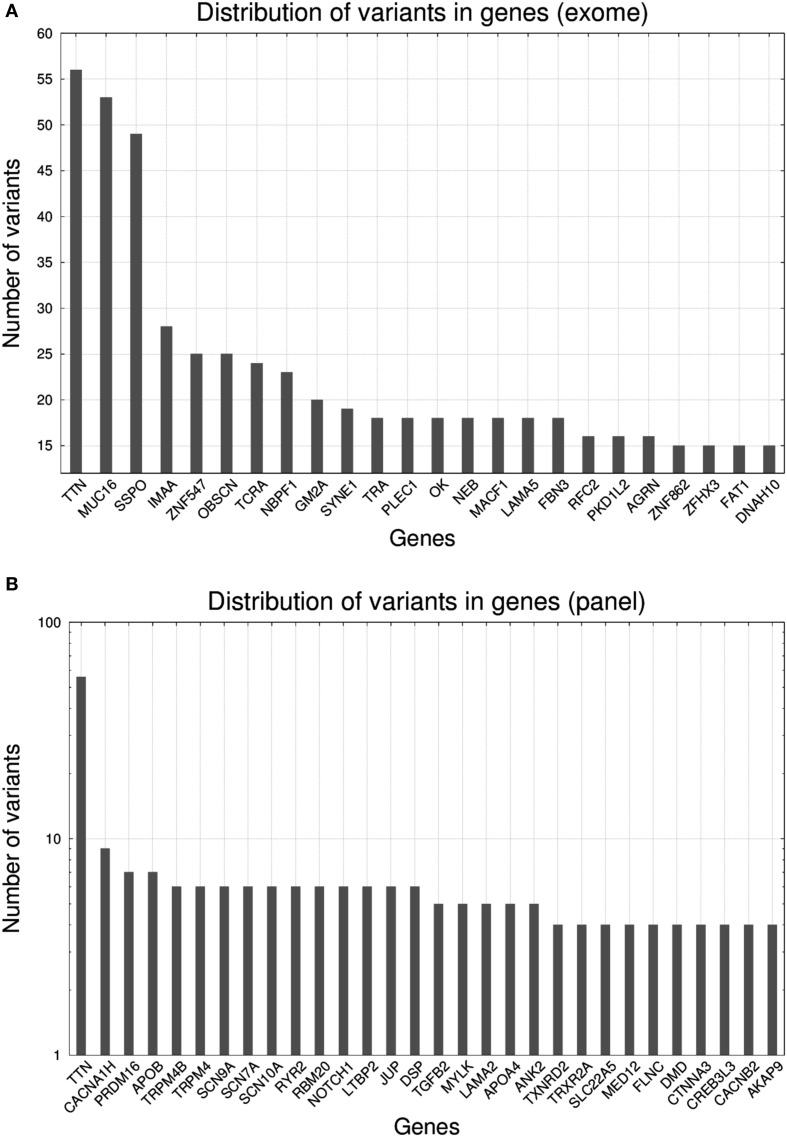
Histograms representing the number of variants per gene* for 50 molecular autopsy cases: (A) when taking into account all exome genes**, (B) when taking into account a gene panel consisting of 233 genes associated to sudden death (note log10 transformation in y-axis), (C) when taking into account exome genes with ≥3 likely pathogenic variants, (D) when taking into account panel genes with ≥1 likely pathogenic variant. *Non-coding RNA loci were excluded from the figures (e.g., AK093733). **Fourteen PCDHG[AB][1-9] loci (protocadherin gamma subfamily A and B) were excluded yet in total they carried 367 variants.